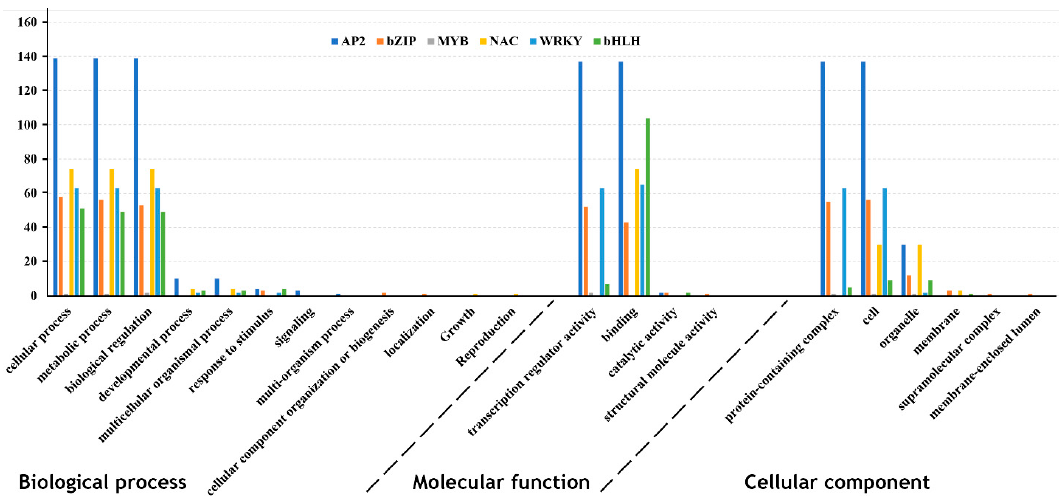
Figure 1. Gene ontology classification of the CBCVd-responsive hop TFs describing the molecular functions, biological processes and cellular components. The analysis was performed using the Blast2Go software (command line version).